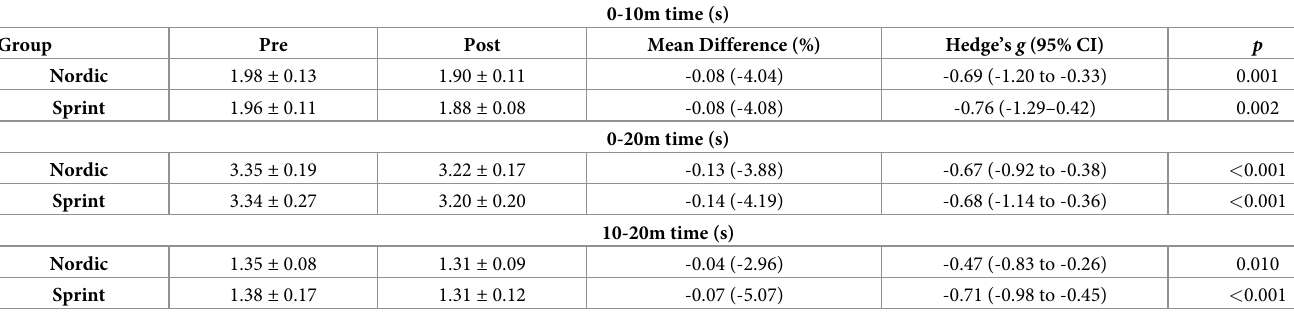
Table 9. Pairwise comparisons of sprint measures between Nordic and sprint training groups.